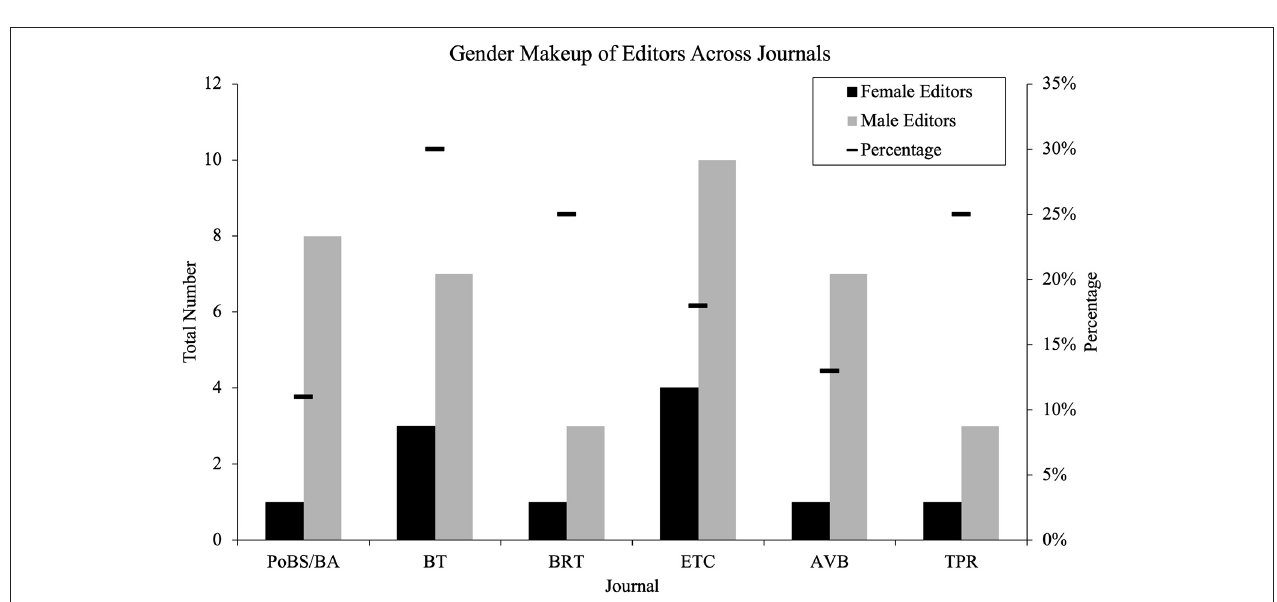
FIGURE 3 | Percentage of female authors by authorship positions by